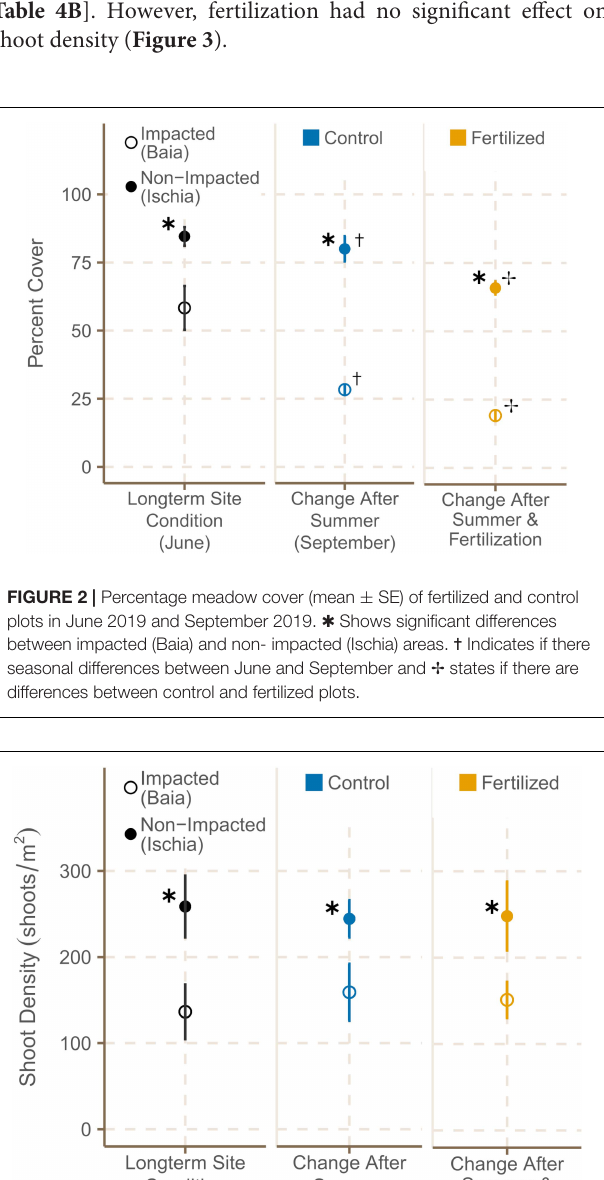
FIGURE 4 | Average epiphyte biomass ( ± SE) of P. oceanica shoots in control and fertilized plots at the different sites in June and September 2019. (cid:81) Shows significant differences between impacted (Baia) and non- impacted (Ischia) areas and (cid:66) indicates if there are differences between control and fertilized